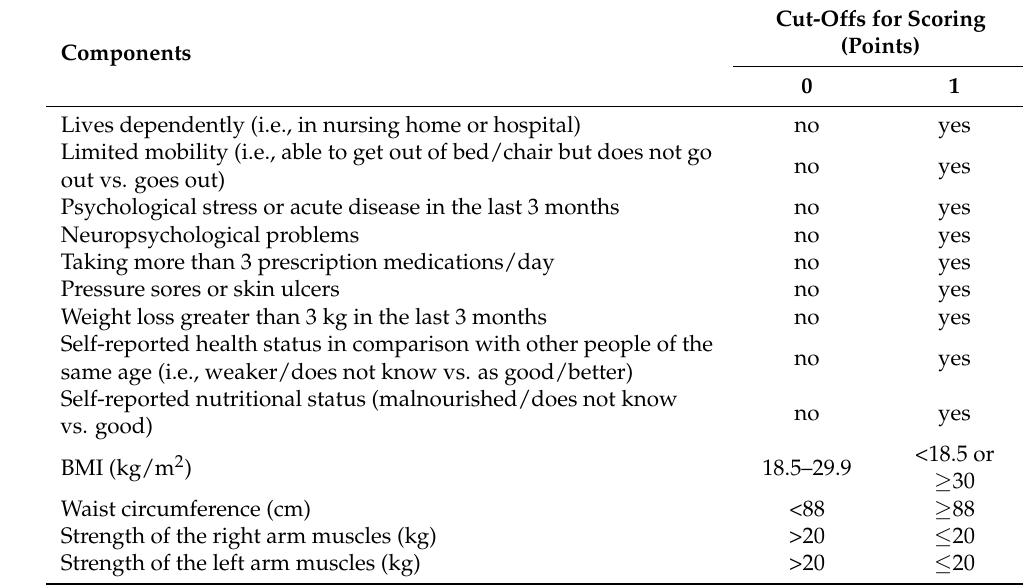
Table 3. The Health-related Limitations Score (H-LS)—components data and scoring.